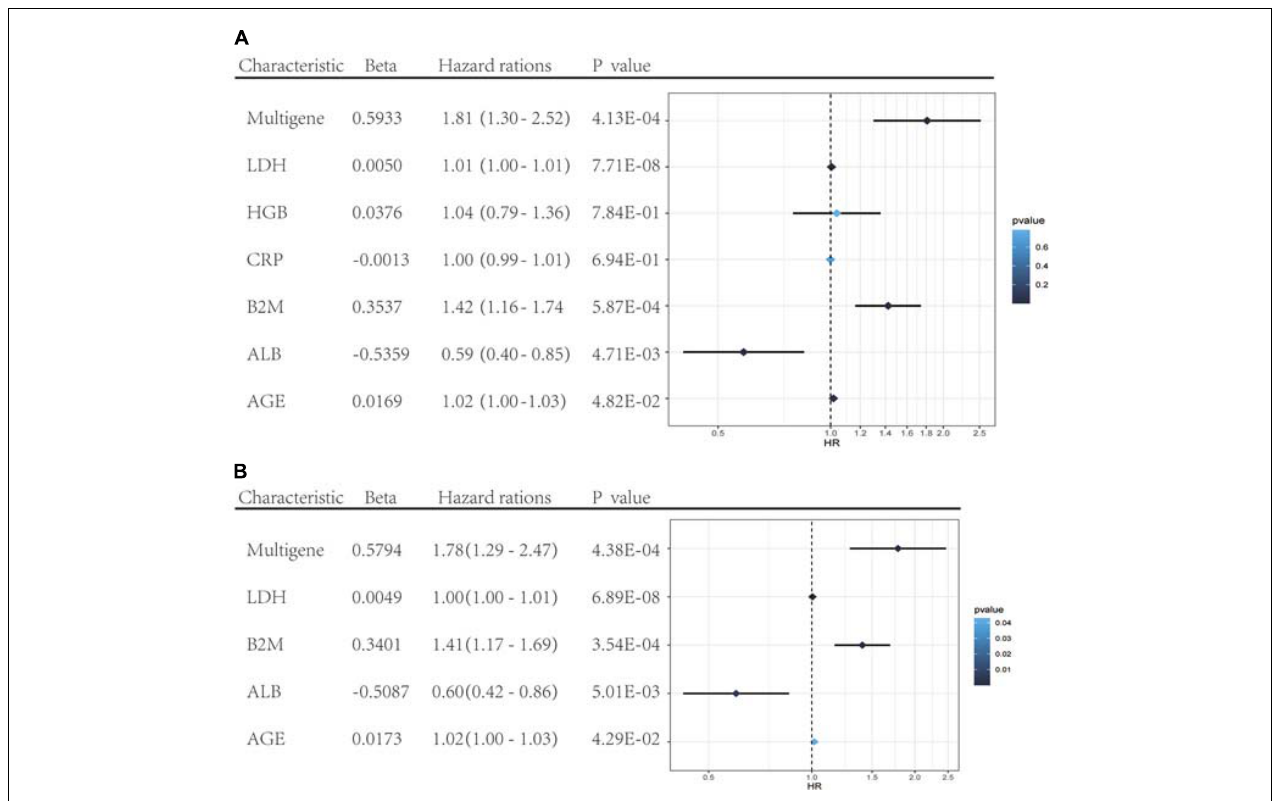
FIGURE 5 | Forest plots of the multivariate and univariate Cox regression analysis in GSE24080 cohorts. (A) Forest plot of the univariate Cox regression analysis OS of the clinical factors and risk score. (B) Forest plot of the multivariate Cox regression analysis OS of clinical factors screened by univariate Cox analysis and risk score. Beta values represent the coefficient index β for each clinical